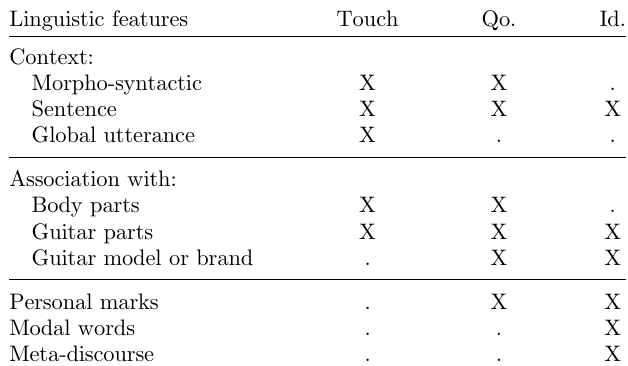
Table 6. Observed parameters (relationship with the sense of touch abbr. Touch, quali fi ed object abbr. Qo., and implication in discourse abbr. Id.) and helpful linguistic features. Linguistic